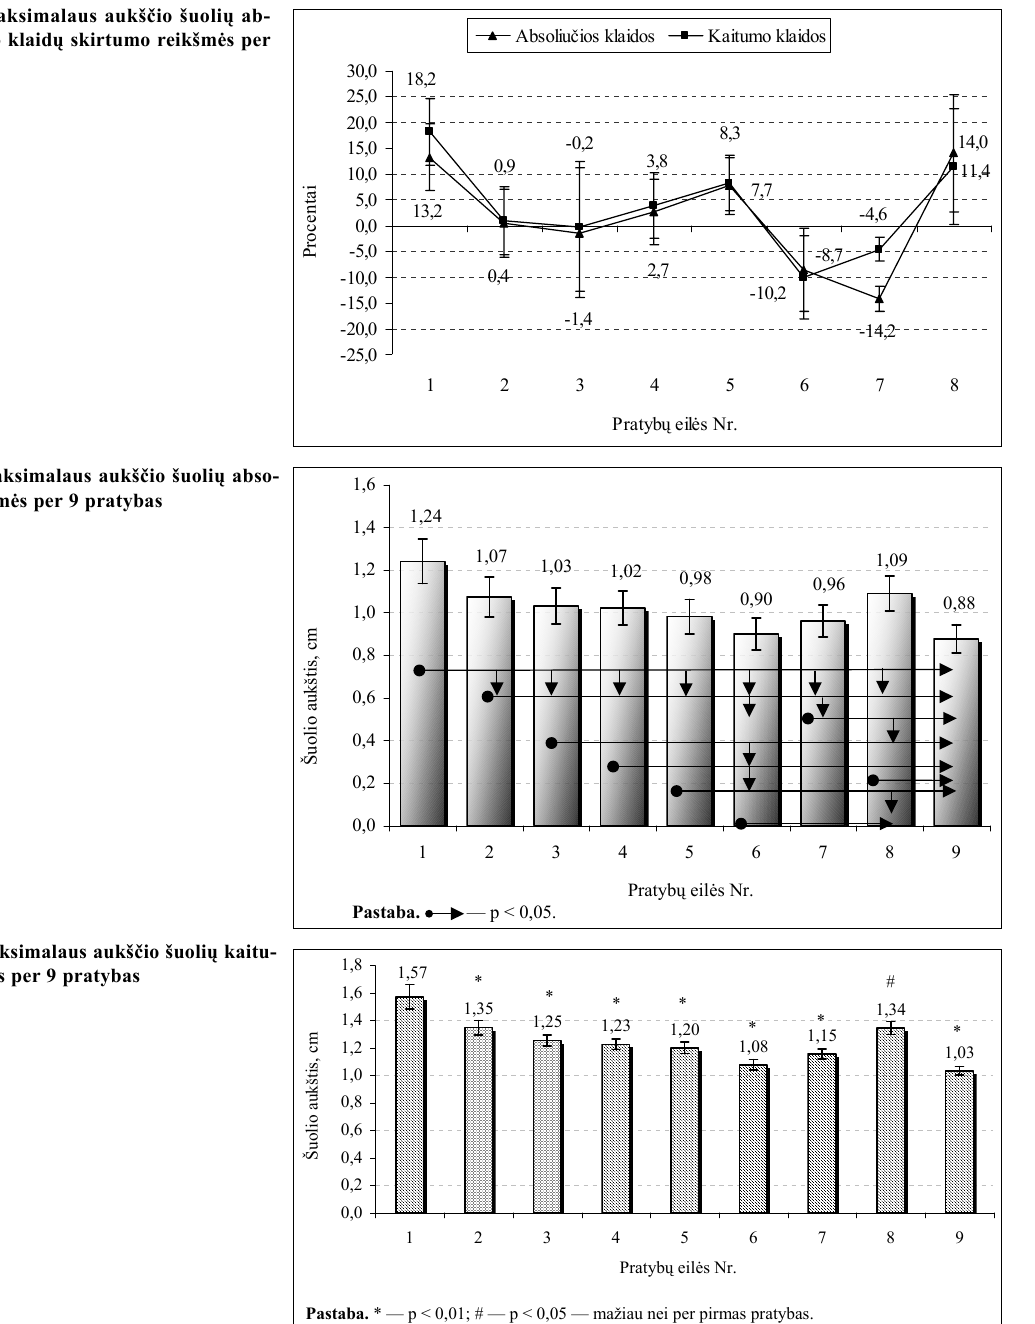
mingas (p < 0,05), kaitumo — nereikšmingas (p > 0,05). MAŠ, šuoli ų tikslumas pager ė